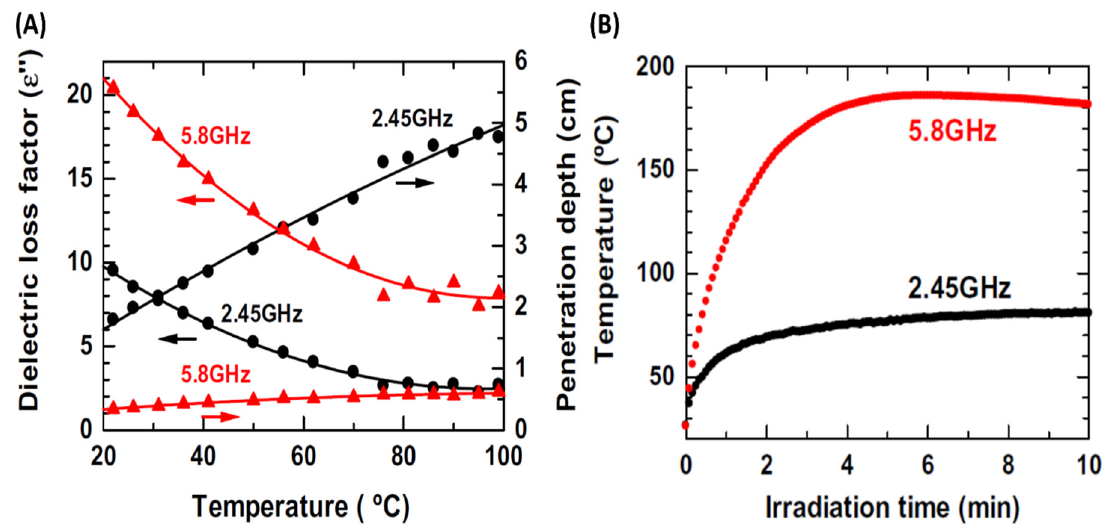
Figure 3. ( A ) Dielectric loss factors (left vertical axis) and penetration-depth (on right) plotted vs. Temperature for 2.45 GHz and 5.8 GHz. ( B ) Temperature vs. time profiles for the two frequencies after Mw-irradiation by the powdered TiO 2 in the reactor tube. Adapted with permission from Elsevier B.V. Copyright 2009 Elsevier B.V.